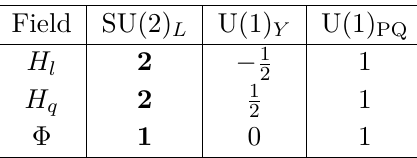
Table 1 . Scalar sector content: H q is the Higgs doublet that couples to the SM quarks, H l is the doublet coupling to the SM leptons, and Φ is the SM-singlet PQ-charged